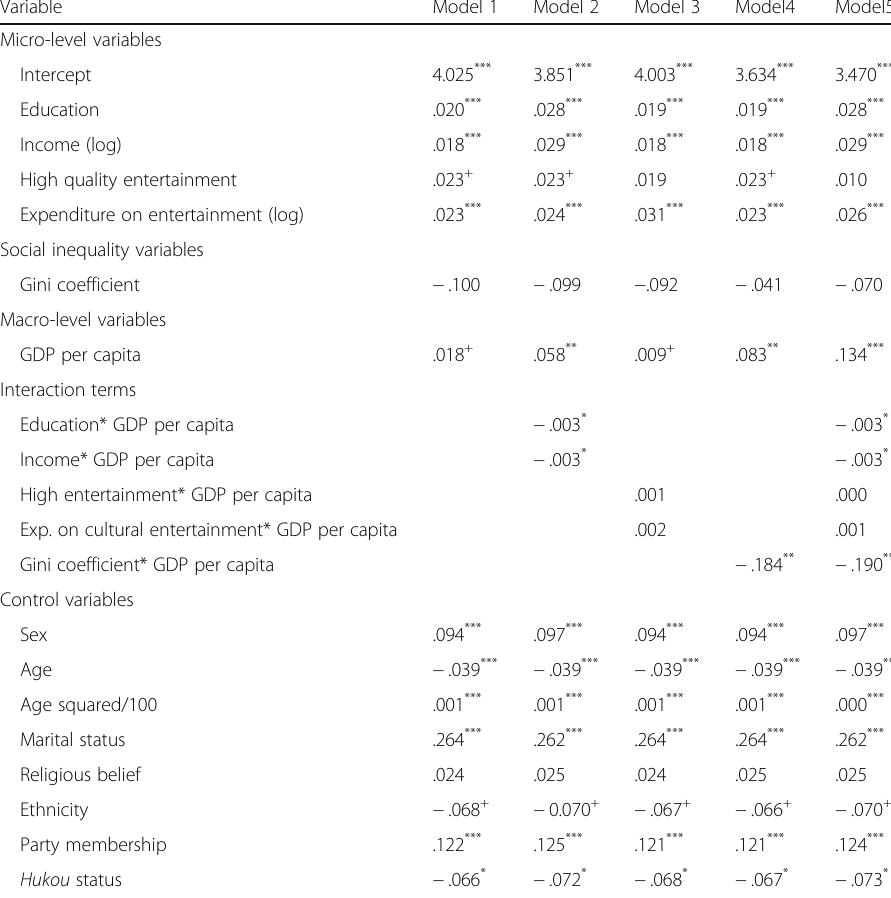
Table 3 Three basic social factors and subjective well-being, N = 9102